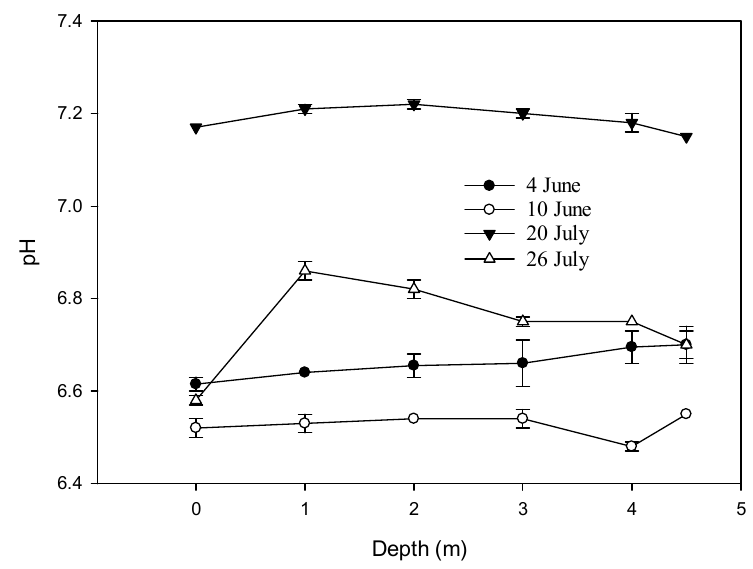
Figure 7. pH changes at each depth.